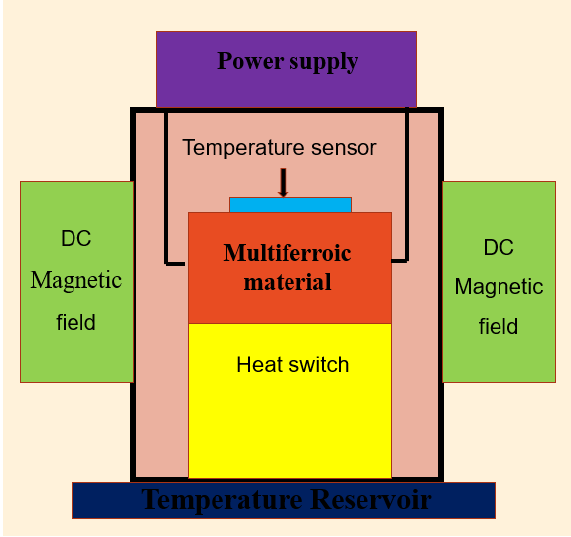
Figure 8. Schematic of multicaloric testing system. Image modified and adapted from Reference [80].